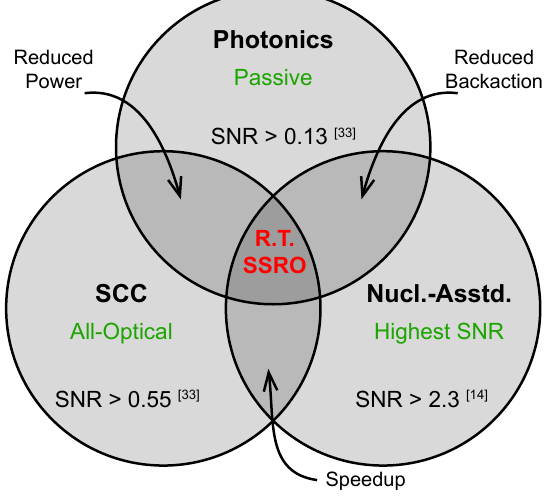
Figure 7. Complementary approaches for enhanced spin readout. Existing techniques have advantages for particular applications. Future research can consider the potential for combining multiple techniques in order to achieve fast, high-fidelity, single-shot readout (SSRO) of the NV center’s electron spin at room temperature. The highest reported traditional PL SNR, as well as the SCC SNR, are from Shields et al. [33]. The highest nuclear assisted SNR is from Neumann et al.